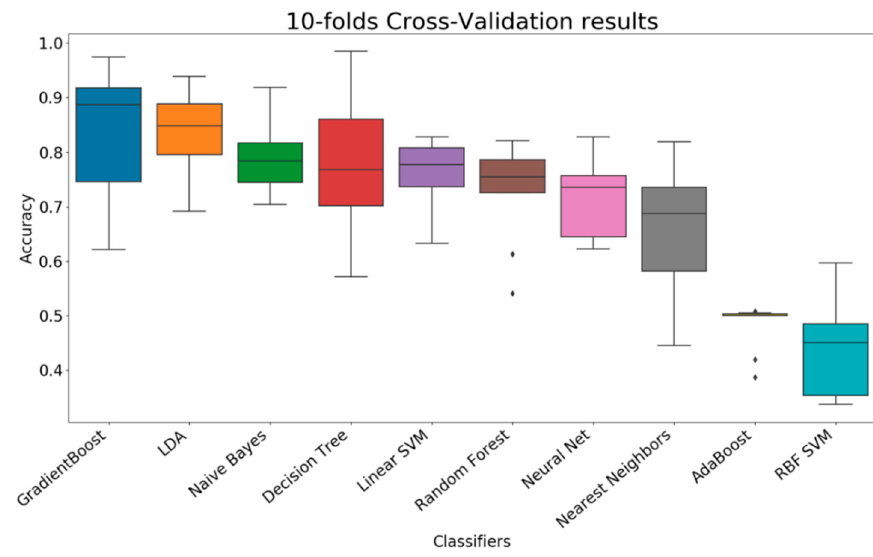
Figure 6. Cross-validation results for all features (box plot). Table 5. Cross-validation results for all